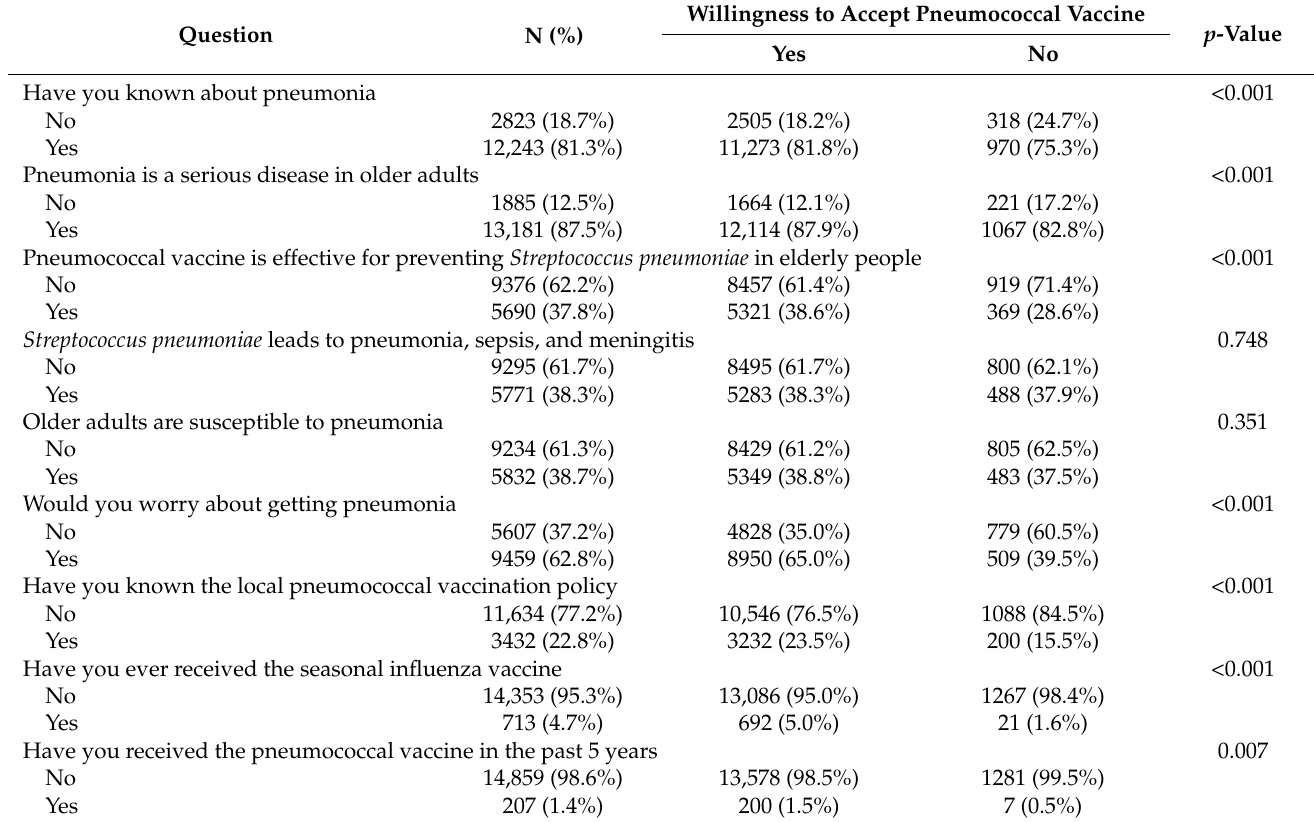
Table 2. Knowledge and perception for pneumonia and vaccinations according to the willingness to accept pneumococcal vaccine in the elderly